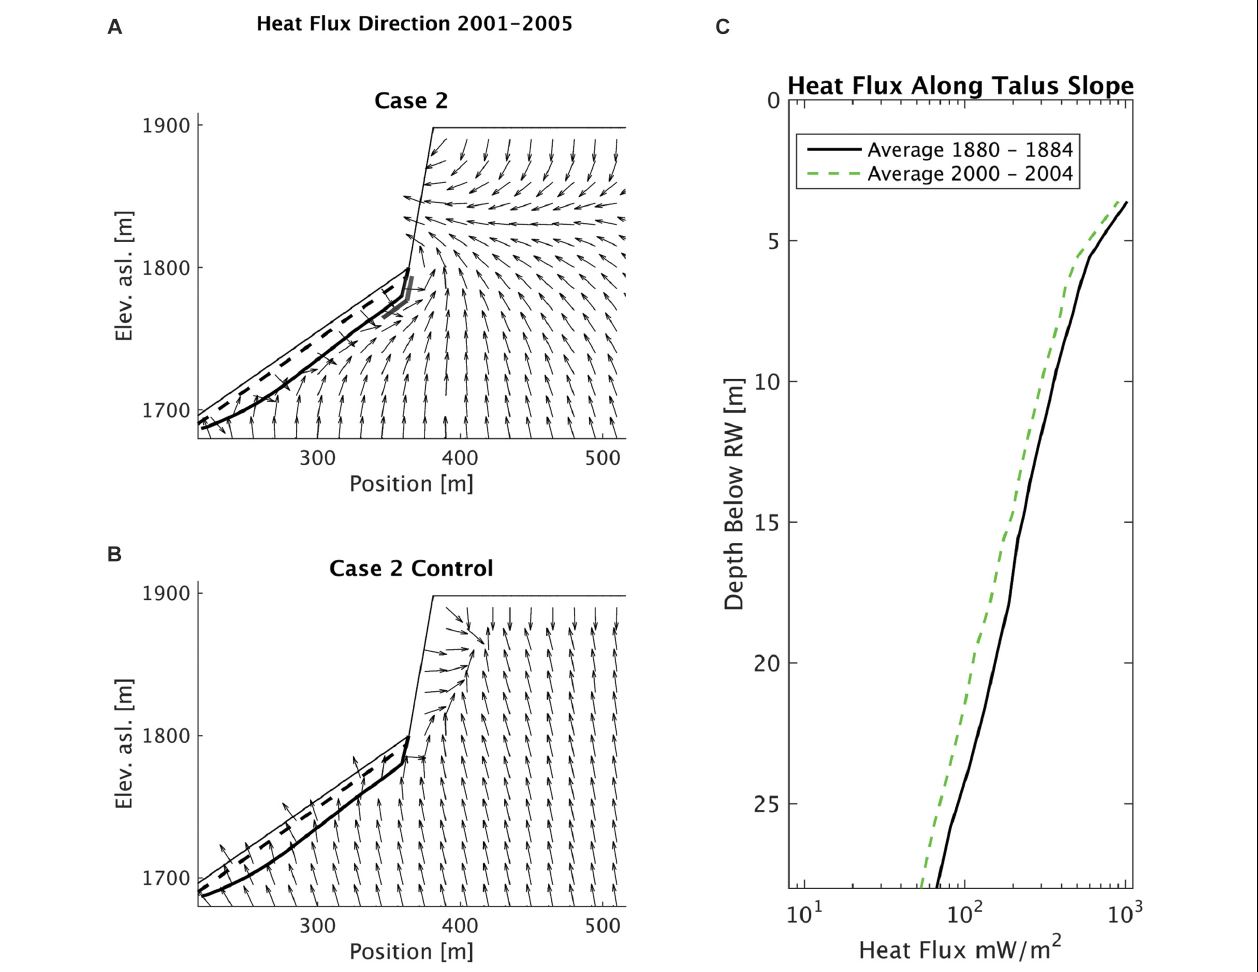
FIGURE 5 | (A,B) Heat flux directions over the 5-year period 2001–2005 for Case 2 (A) and Case 2 Control (B) simulations. The simulations are run with elevation 1700–1900 m asl., with mineral thermal conductivity k = 3.5 W/m ◦ C and geothermal heat flux 50 mW/m 2 . Snow covers are implemented along the talus slope for both simulations by means of nF = 0.2. For the control simulation (B) , nF = 0.2 is also implemented along the steep rock wall. (C) Average heat fluxes along the backside of the talus slope from 3 to 30 m depth below the talus apex [marked with gray line in panel (A) ] in 1881–1885 and 2001–2005 for the Case 2 simulation with snow-free rock